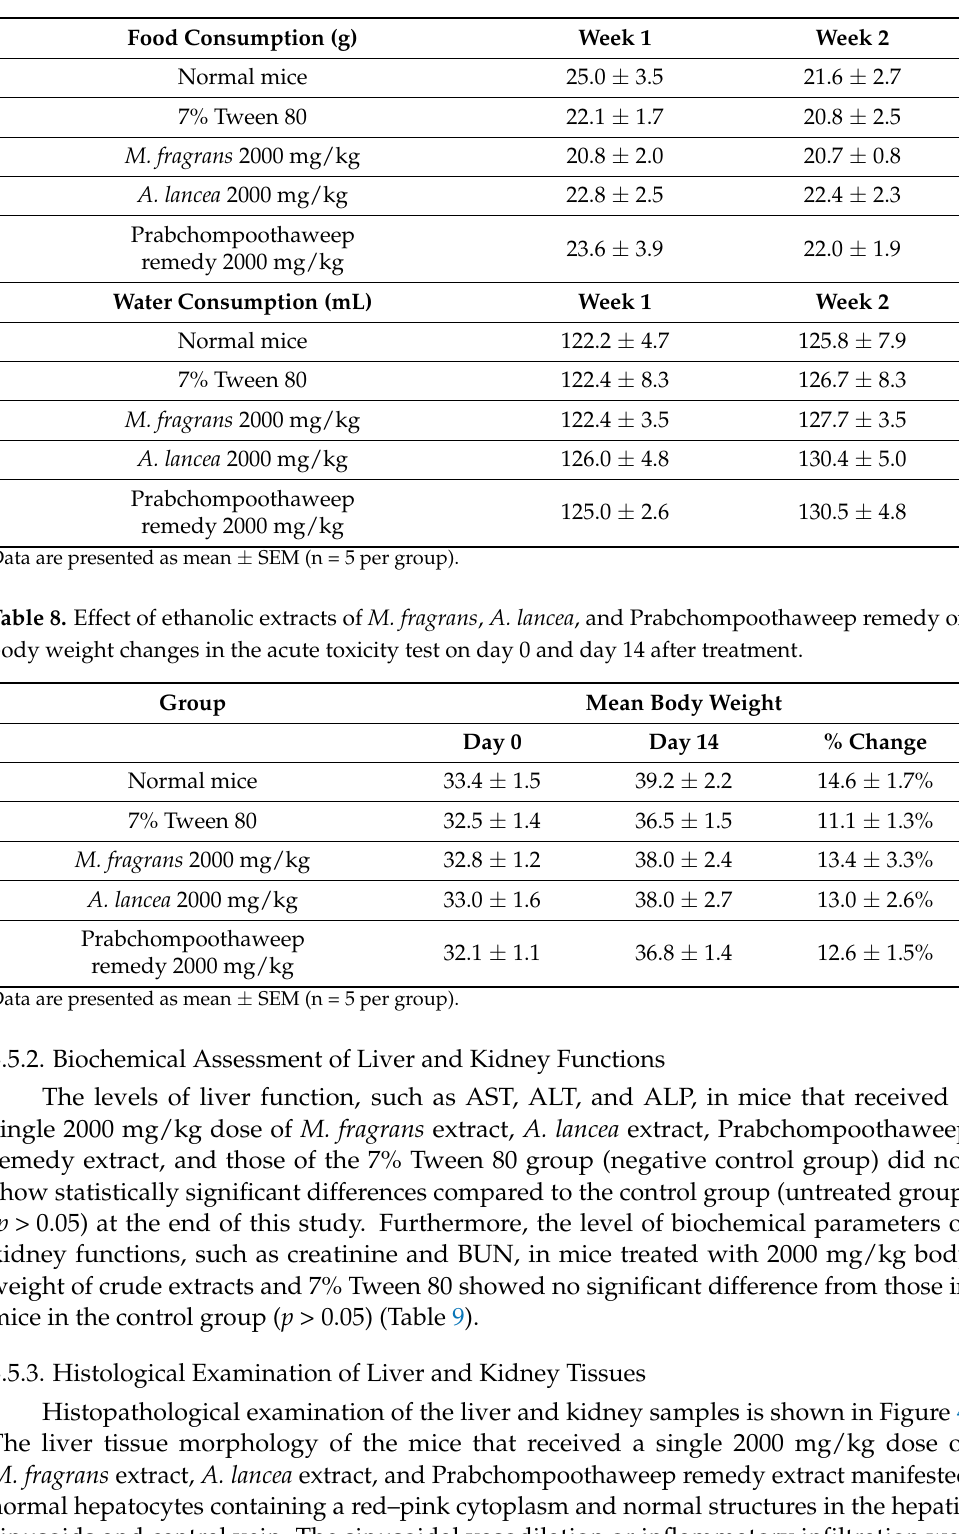
Table 7. Effect of ethanolic extracts of M. fragrans , A. lancea , and Prabchompoothaweep remedy on food and water uptake in the acute toxicity test at week 1 and week 2 after treatment.